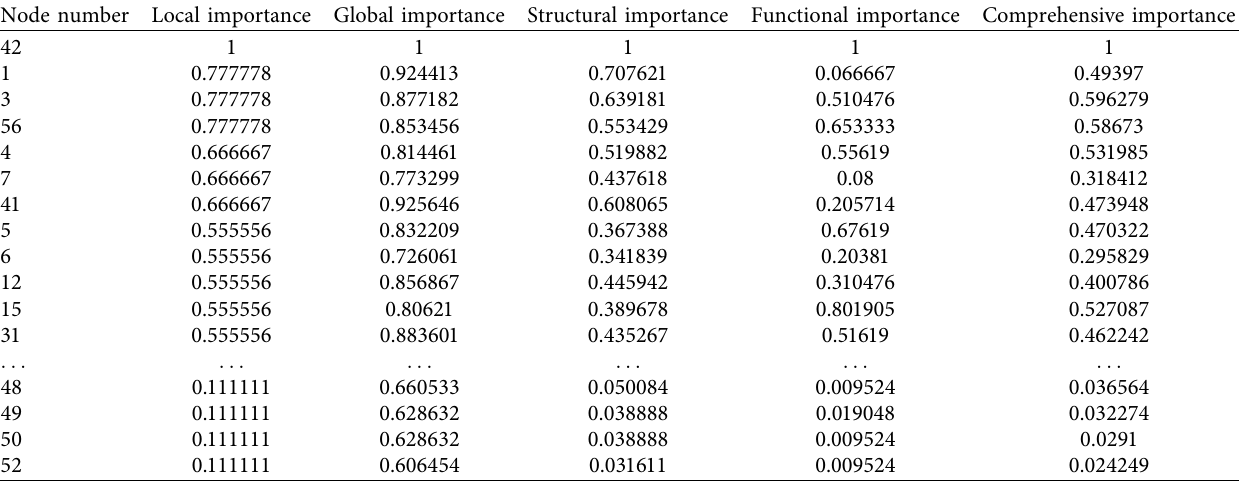
Table 4: Part of node importance results.